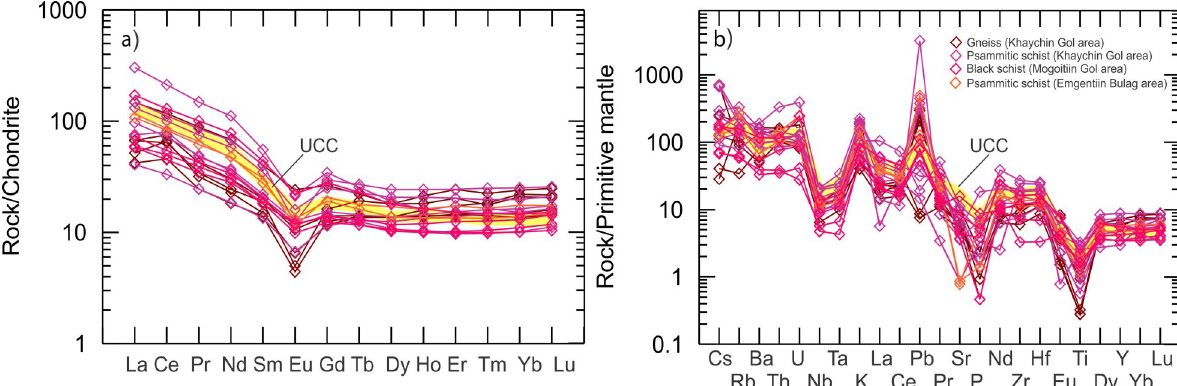
/Al O ) vs. log(Fe O /K O) classification diagram (Herron, 2 2 3 2 3 2